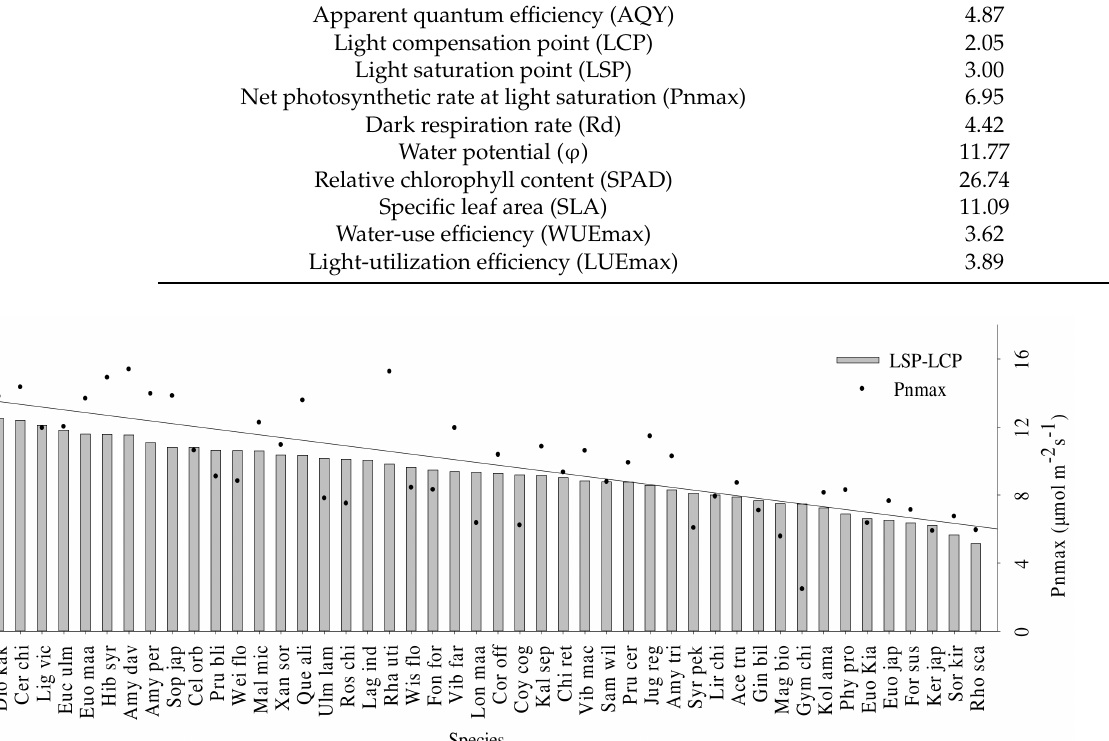
Figure 4. The relationship between light intensity range and Pnmax of different species. Each bar represents the mean of five replicates. LSP, LCP and Pnmax are light saturation point, light compen- sation point, and net photosynthetic rate at light saturation, respectively. Species abbreviations are shown in Table